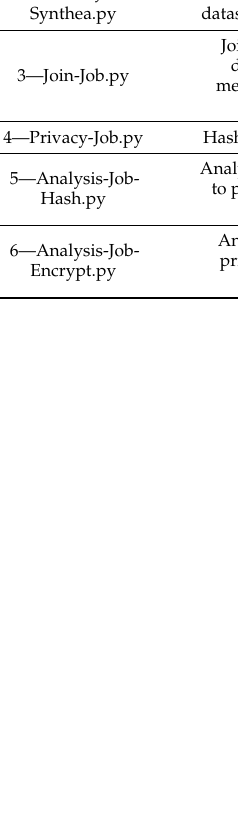
Figure 13. Elapsed times for executions of the PySpark program under different configurations.